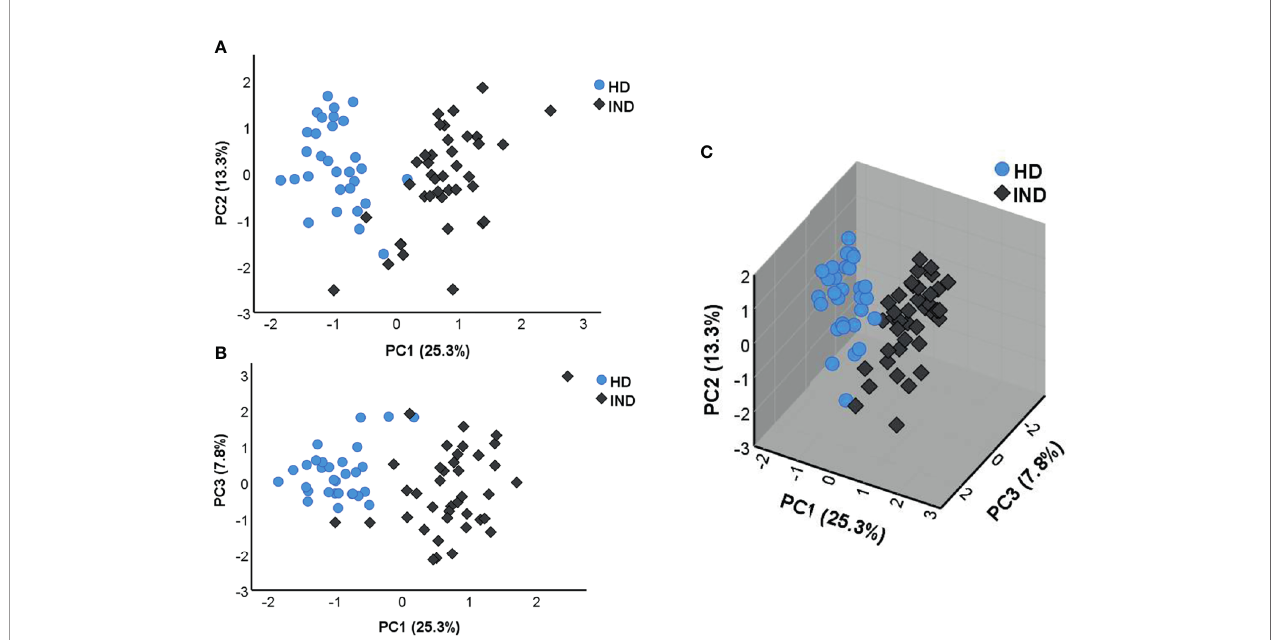
FIGURE 3 | Principal component analysis (PCA) applied on NRQ values of 106 analyzed genes from IND patients (IND, dark rhombus) and healthy donors (HD, blue circles). (A) PCA score plot of principal components 1 (PC1) and 2 (PC2) on the x and y axes, respectively. (B) PCA score plot of principal components 1 (PC1) and 3 (PC3) on the x and y axes, respectively. (C) 3D graphic representing the three principal components 1, 2, and 3 (PC1, PC2, and PC3). The proportion of variance captured for principal components is given as a percentage and indicated on the axis next to the corresponding principal